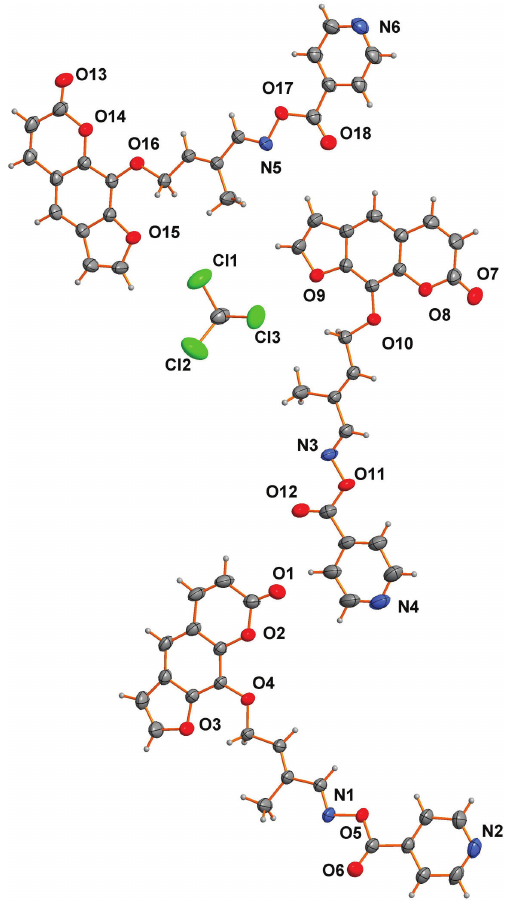
The asymmetric unit of the title crystal structure is shown in the figure. Table 1 contains crystallographic data and Table 2 contains the list of the atoms including atomic coordinates and displacement parameters.